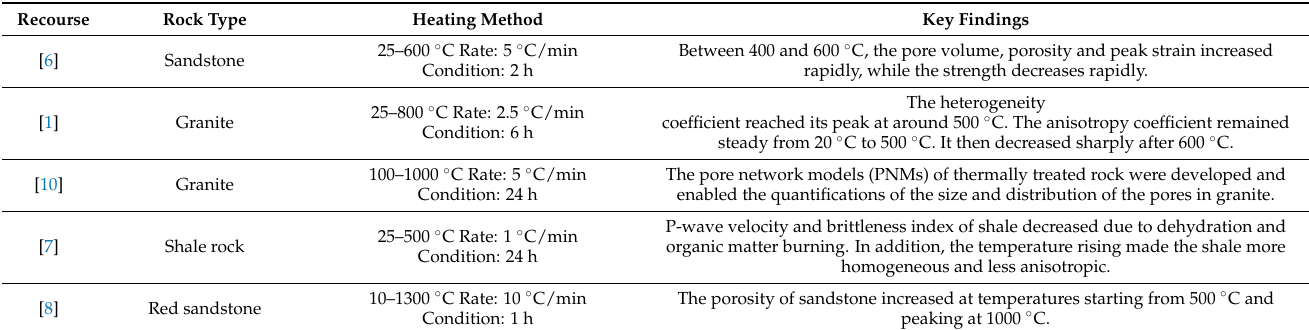
Table 1. Recent literature on the thermal effects of